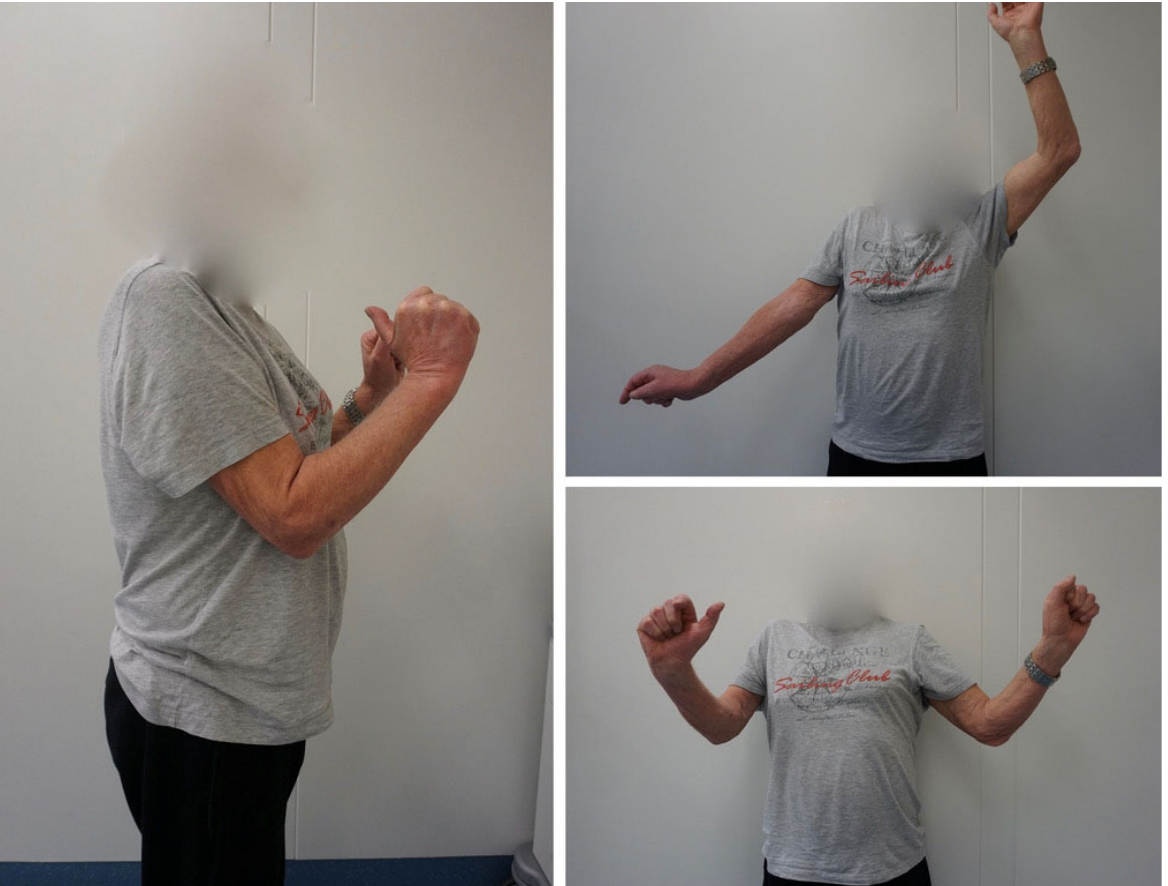
Figure 1. Postoperative result of a triple nerve transfer (spinal accessory nerve to suprascapular nerve, radial nerve fascicle to axillary nerve, median nerve fascicle to brachialis muscle) in an aged patient after complete paralysis of his deltoid, supra-/infraspinatus, biceps and brachialis muscle, showing good shoulder abduction and elbow flexion at M3 strength level.